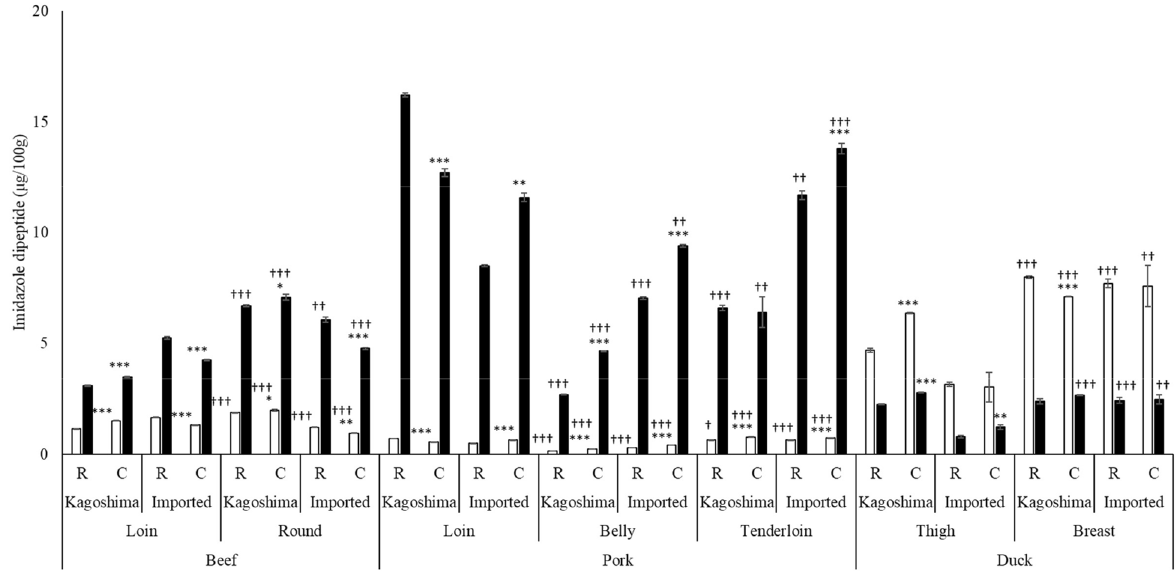
Figure 1. Comparison of imidazole dipeptides in raw and cooked meat extracts. R raw, C cooked. Anserine: white bars, carnosine: black bars. Asterisk indicates P < 0.05 vs. raw. Double asterisk indicates P < 0.01 vs. raw. Triple asterisk indicates P < 0.001 vs. raw. Dagger indicates P < 0.05 vs . loin (beef and pork) or thigh (duck). Double dagger indicates P < 0.01 vs. loin (beef and pork) or thigh (duck). Triple dagger indicates P < 0.001 vs. loin (beef and pork) or thigh